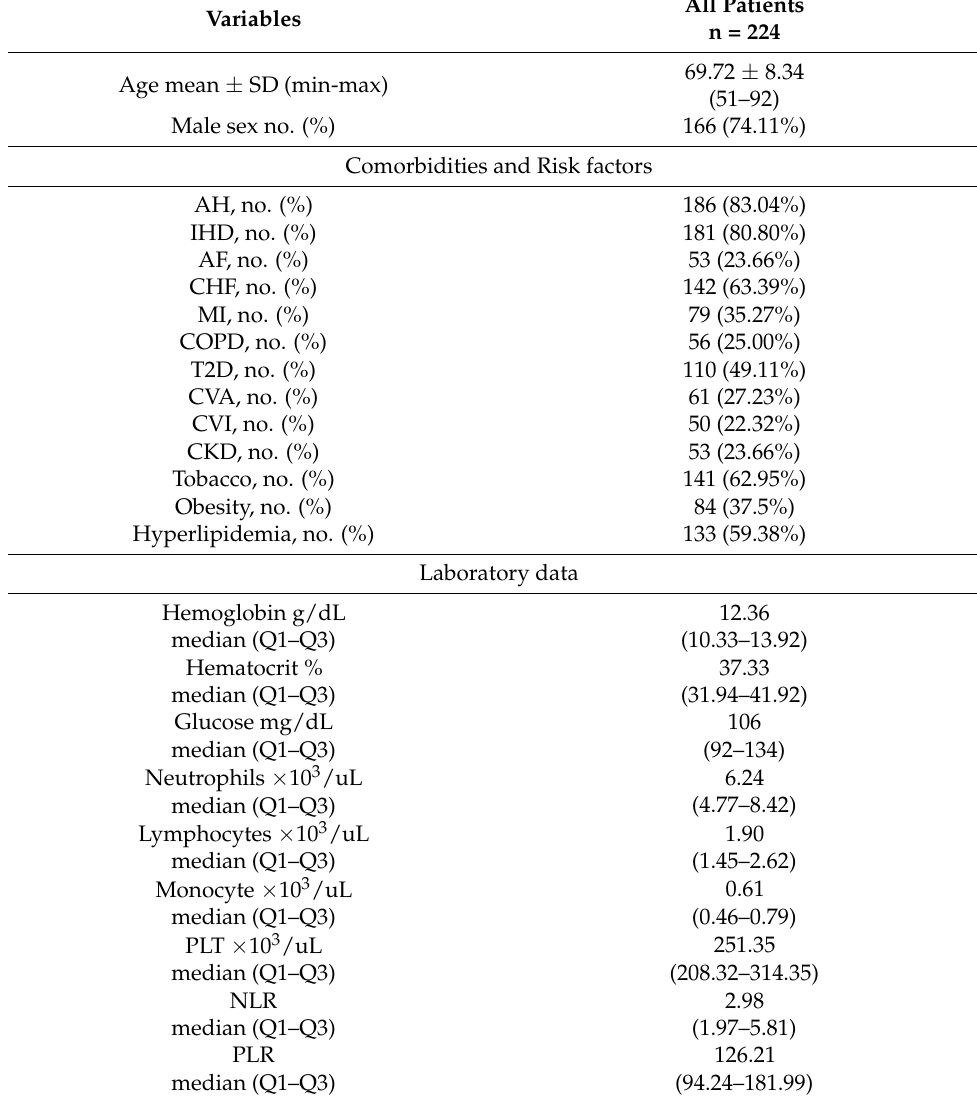
Table 1. Demographic, comorbidities, risk factors, and laboratory findings for all